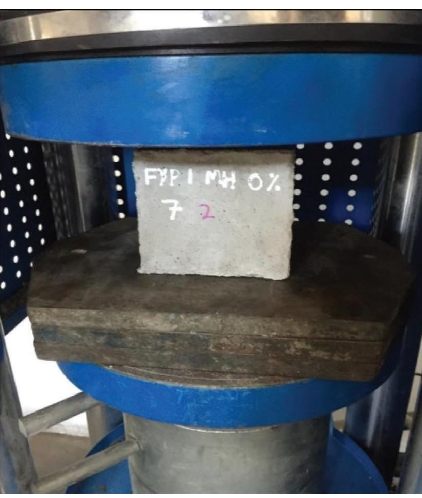
Figure 4: Compression test machine.